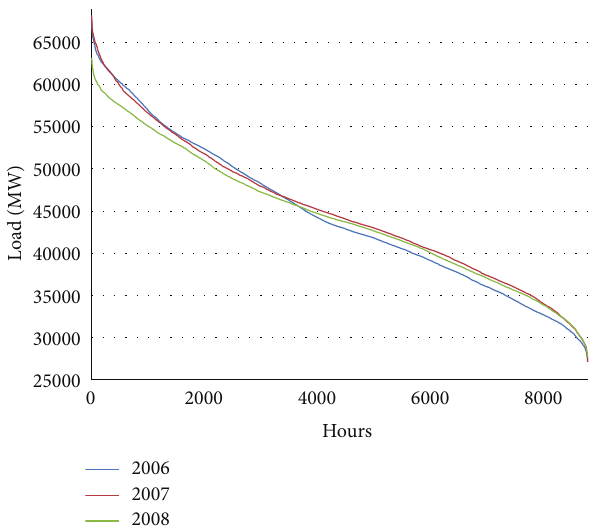
Figure 2: Load duration curves in Nordic power markets from 2006 to